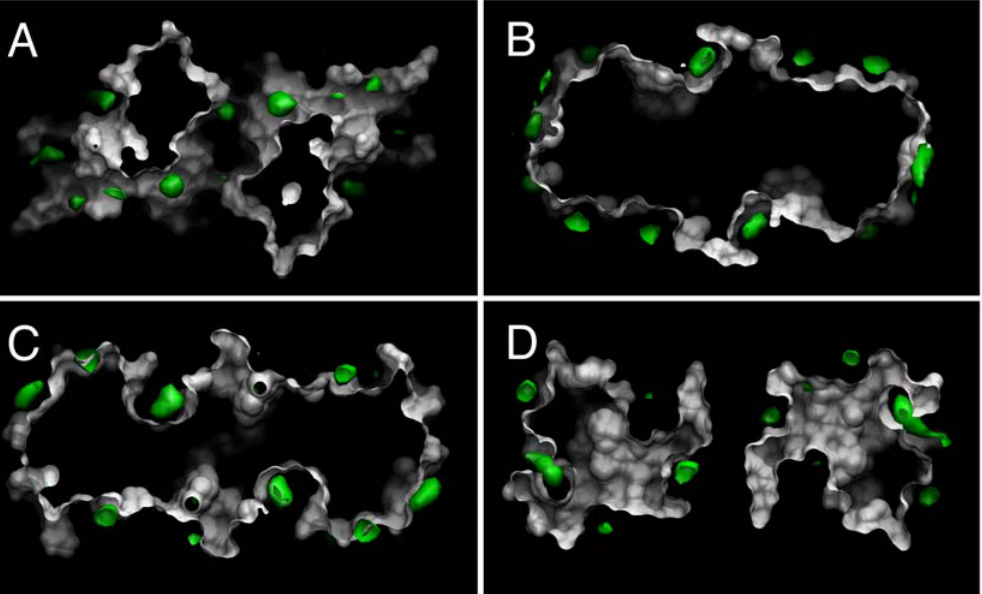
Figure 2. Successive slices (A–D) of the aliphatic carbon atom FragMap (green), generated by mapping propane carbon atoms, and the crystallographic BCL-6 molecular surface (white) taken perpendicular to the two-fold symmetry axis of the protein.